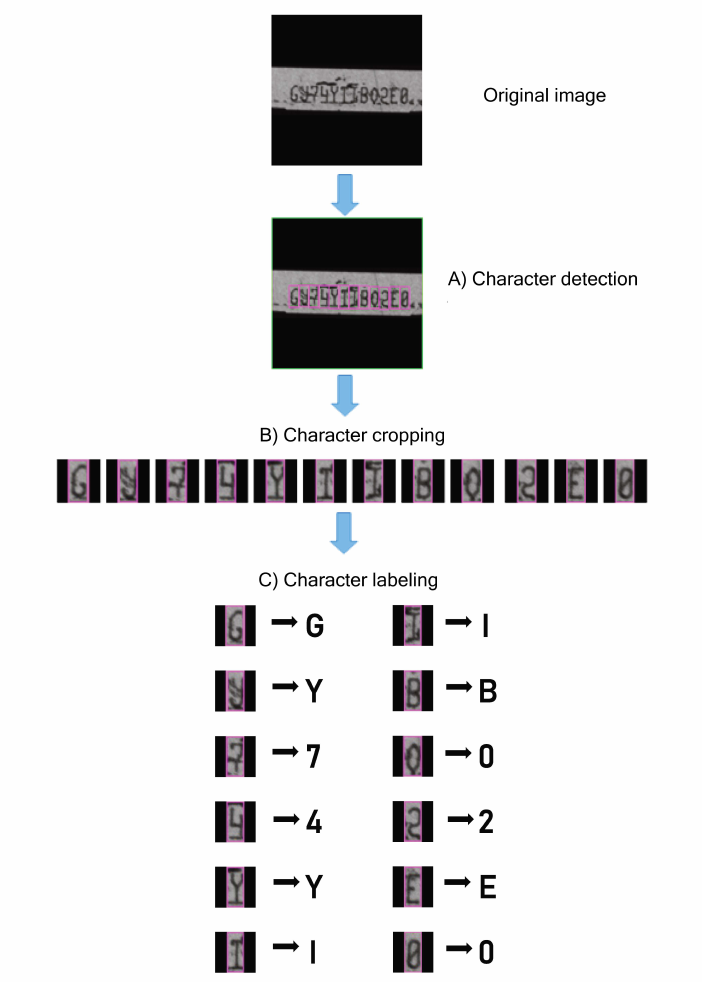
Figure 7. Example of character detection, cropping, and labeling